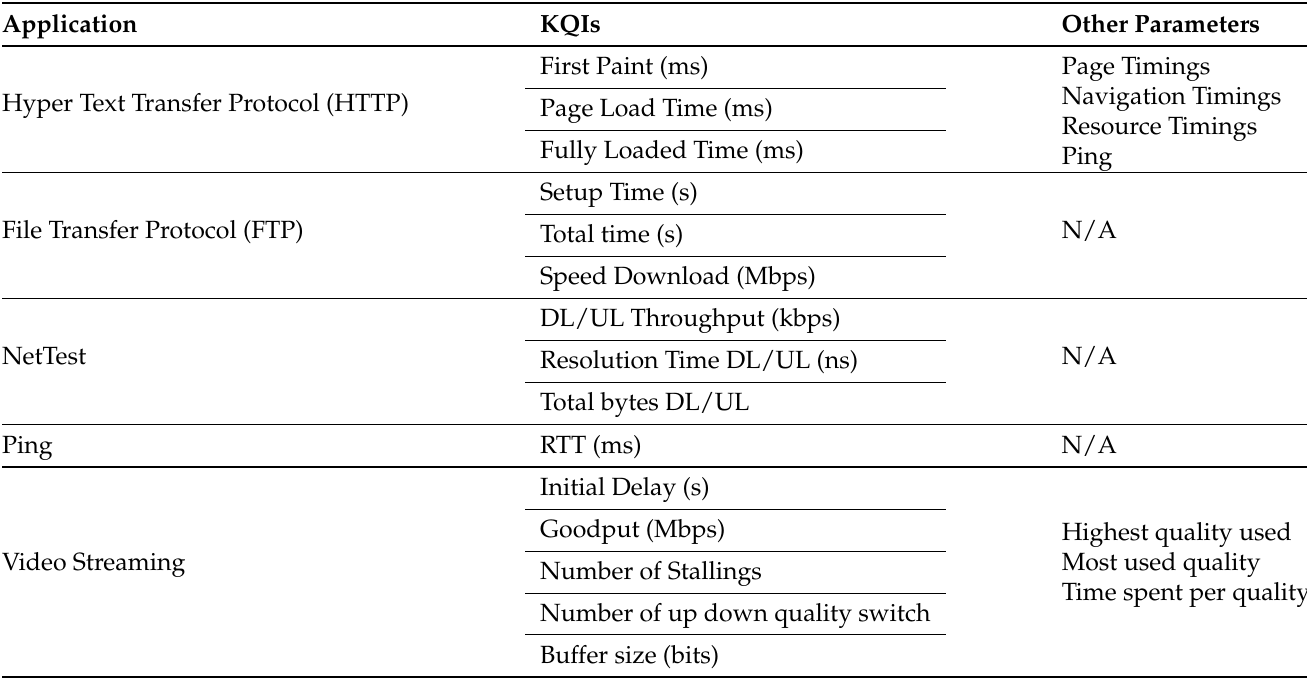
Table 1. Key quality indicators of the service